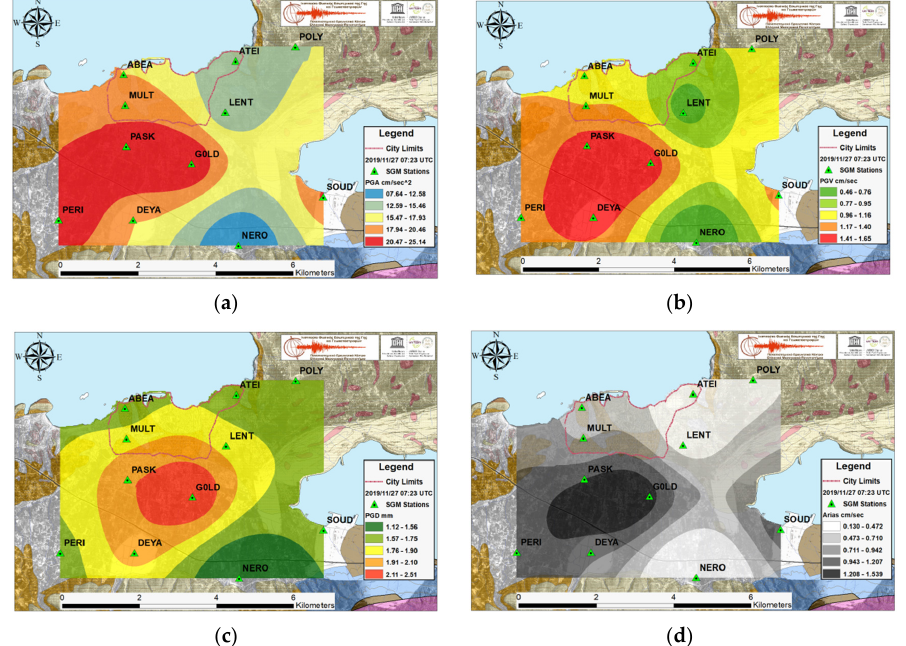
Figure 4. For the EQ.3 strong event, West of Chania, the ground motion parameter spatial distribution results obtained from Ordinary Co-Kriging: ( a ) Peak Ground Acceleration in cm/s 2 ; ( b ) Peak Ground Velocity in cm/s; ( c ) Peak Ground Displacement in mm and ( d ) Arias Intensity in cm/s.